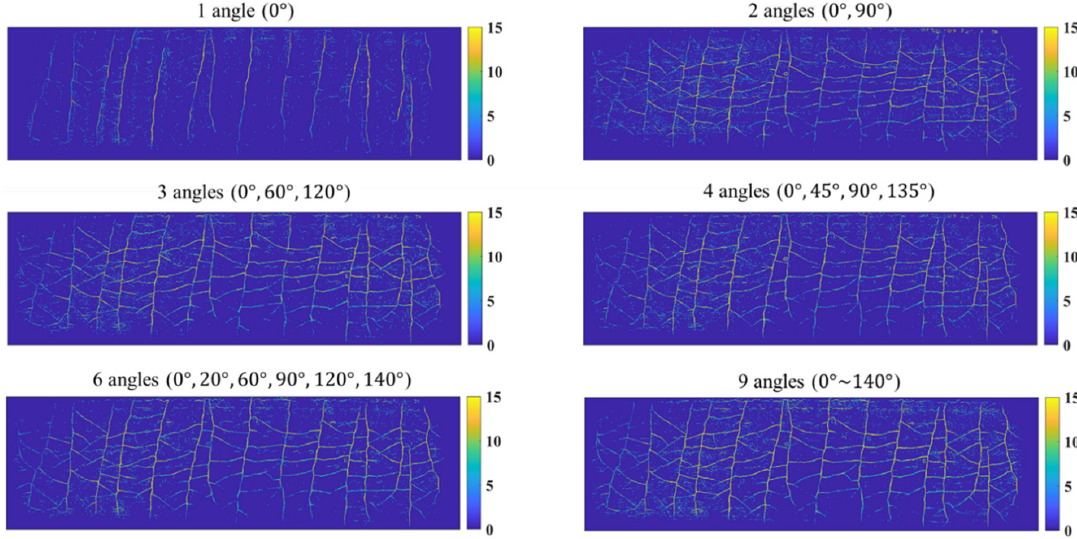
Figure 15. Detection results of six different scanning direction combination schemes.